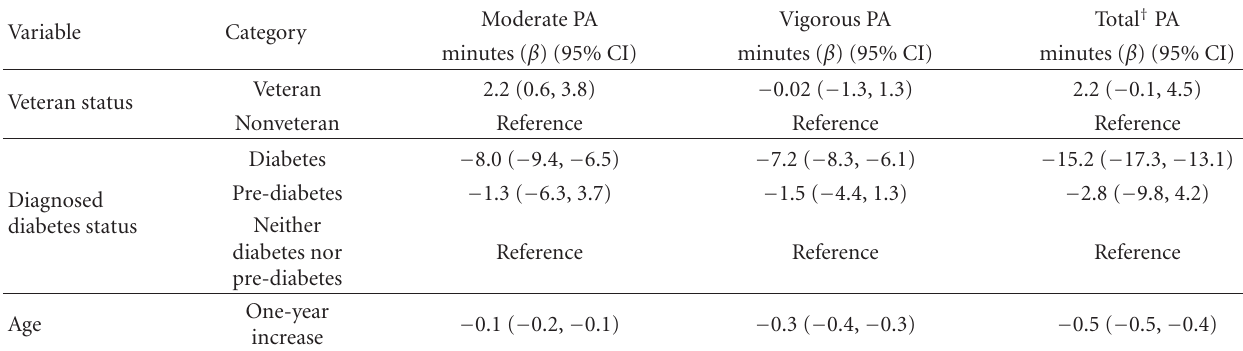
Table 3: Adjusted ∗ estimated di ff erences in mean minutes of moderate, vigorous, and total physical activity (PA) per week among veterans and nonveterans in the United States, 2009 Behavioral Risk Factor Surveillance